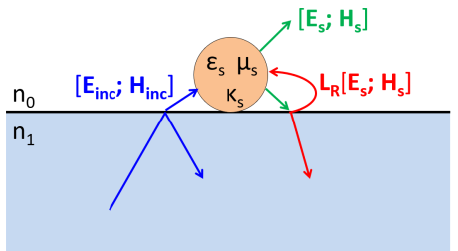
Figure 2. A schematic of the theoretical model to analyze light scattering by a chiral sphere on the substrate. The blue and green arrows represent the path of the incident light ( E inc and H inc ) and scattering light ( E s and H s ). The red arrows represent the light reflected and transmitted at the interface. L R represent the reflection matrix.